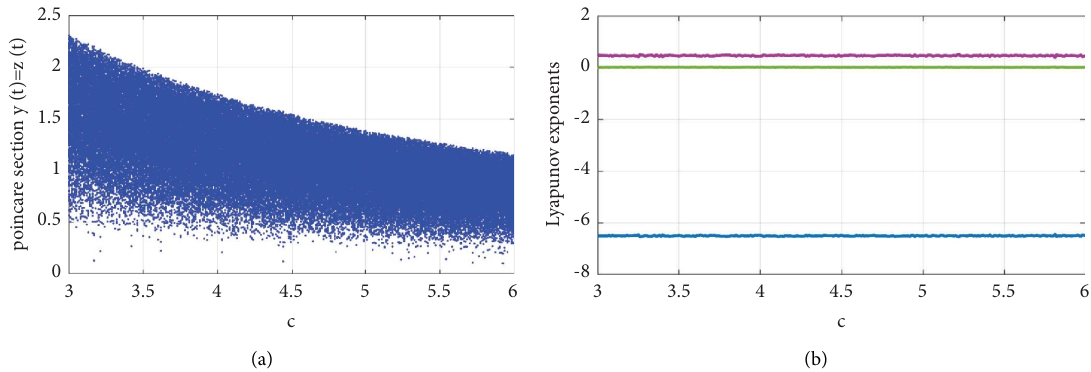
Figure 8: (a) Te system bifurcation diagram and (b) the corresponding Lyapunov exponents, utilizing c as the bifurcation parameter with fxing the other parameters constant such that a � 2 ,b � 7 , f � 8 , g � 11 , and r � 4.